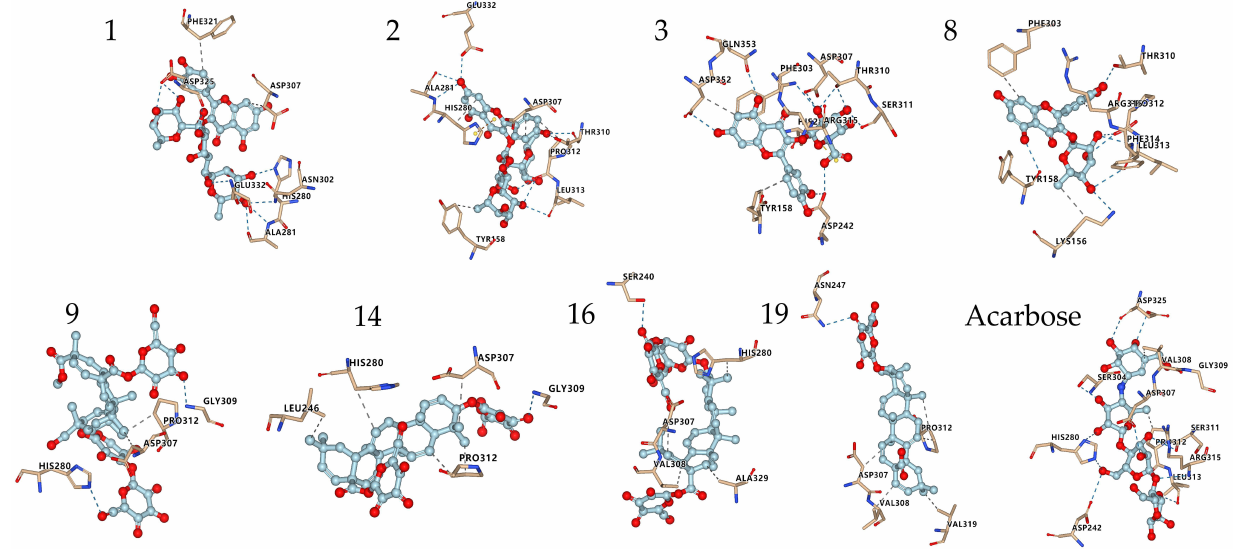
Figure 7. Conformations of the compounds (Table 5) interacting with amino acid residues at the active site of α -glucosidase. Compounds 1 , 2 , 3 , 8 are flavonoids; Compounds 9 , 14 , 16 , 19 are triterpenoid